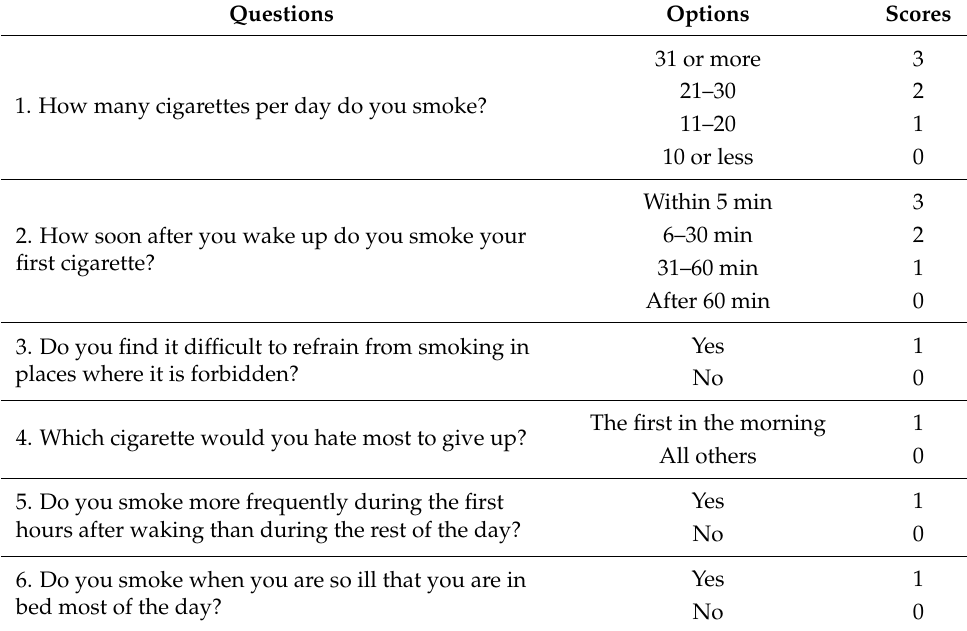
Table 2. FTND questions.